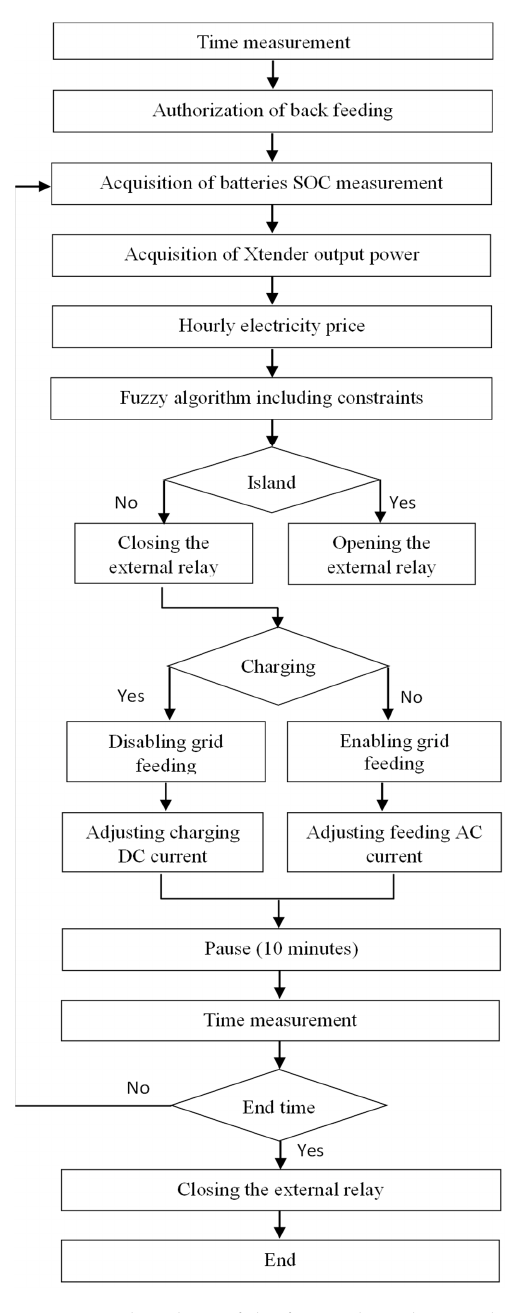
Figure A1. Flowchart of the fuzzy algorithm implementation.